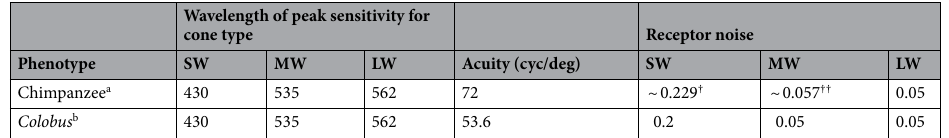
Table 1. Parameters of chimpanzee and colobus vision. † 0.22912878. †† 0.0572822. a Cone sensitivities from 35 ; acuity estimate from 36 ; receptor noise estimated with cone type ratio 1:16:21 for SW:MW:LW from 37 . b Cone sensitivities from 38 that suggested uniform colour vision among Old World monkeys; acuity from macaque estimate of 39 ; receptor noise estimated with cone type ratio 1:16:16 for SW:MW:LW from 40 .